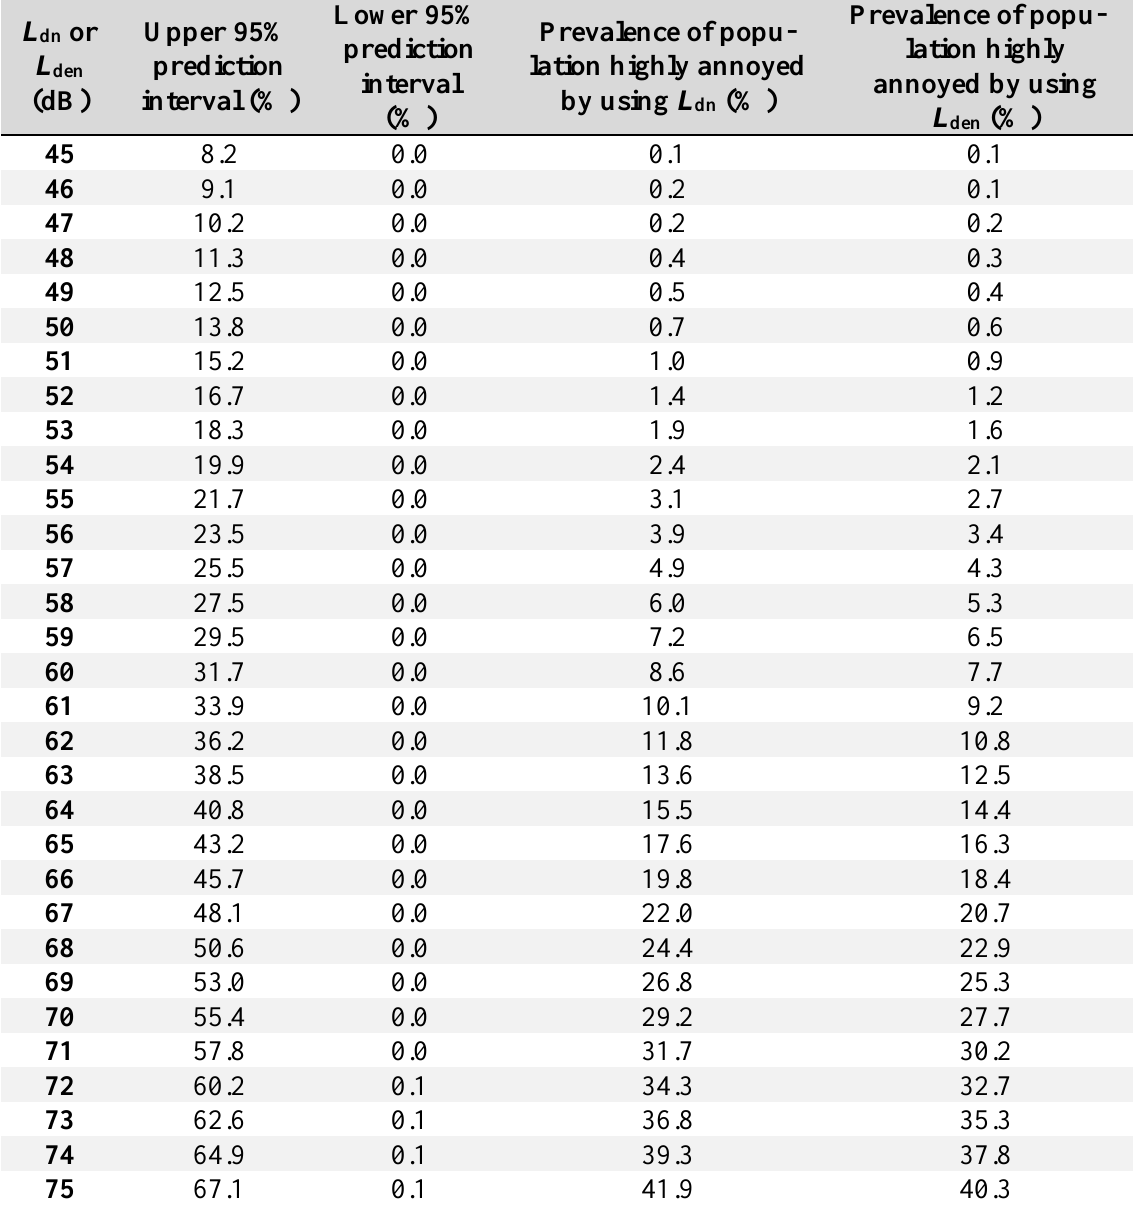
or L for road traffic dn den